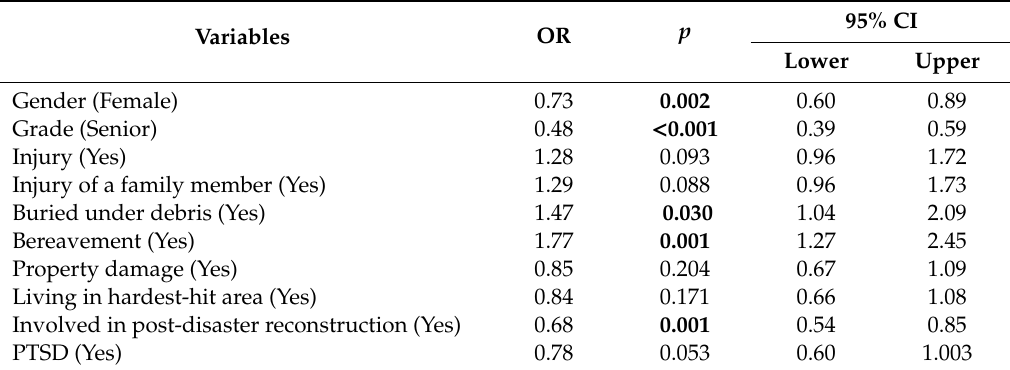
Table 3. Logistic regression analyses on the associations between independent variables and school maladaptation ( N = 1976).